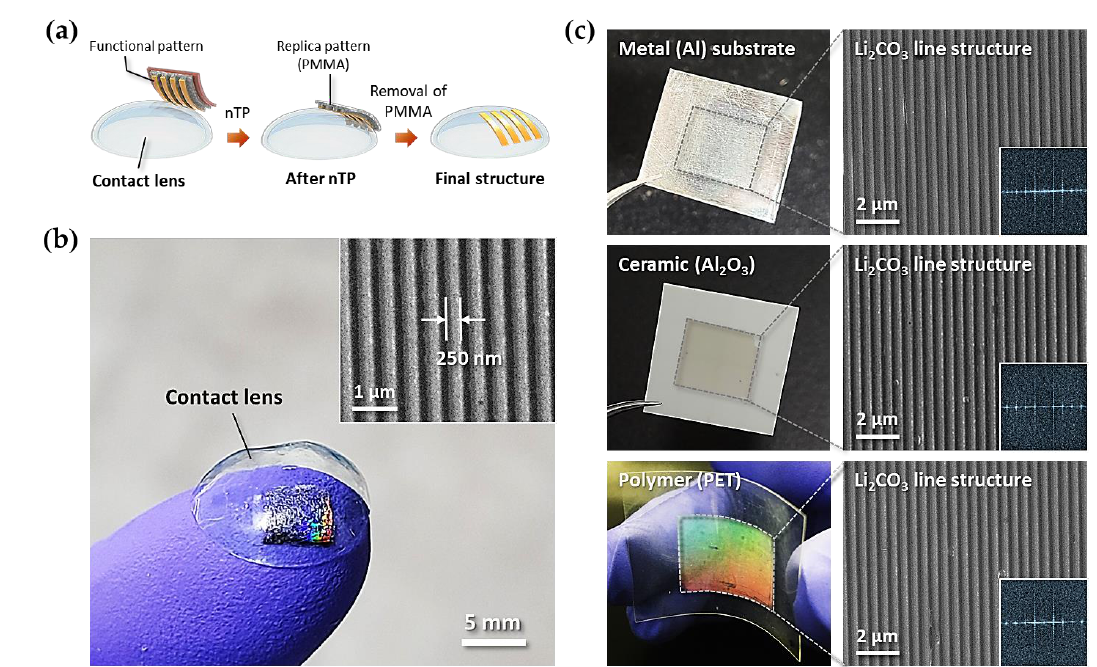
Figure 4. Transfer-printed Li 2 CO 3 nanopatterns on the various substrates. ( a ) Key process of nTP for the fabrication of Li 2 CO 3 nanostructures on a contact lens. ( b ) Photographic image of a Li 2 CO 3 250-nm-line pattern on the soft contact lens. The inset image is the magnified SEM image of the Li 2 CO 3 line pattern on the contact lens. ( c ) Transfer-printed line patterns on various material surfaces, in this case metal (Al), ceramic (Al 2 O 3 ), and polymer (PET) substrates.